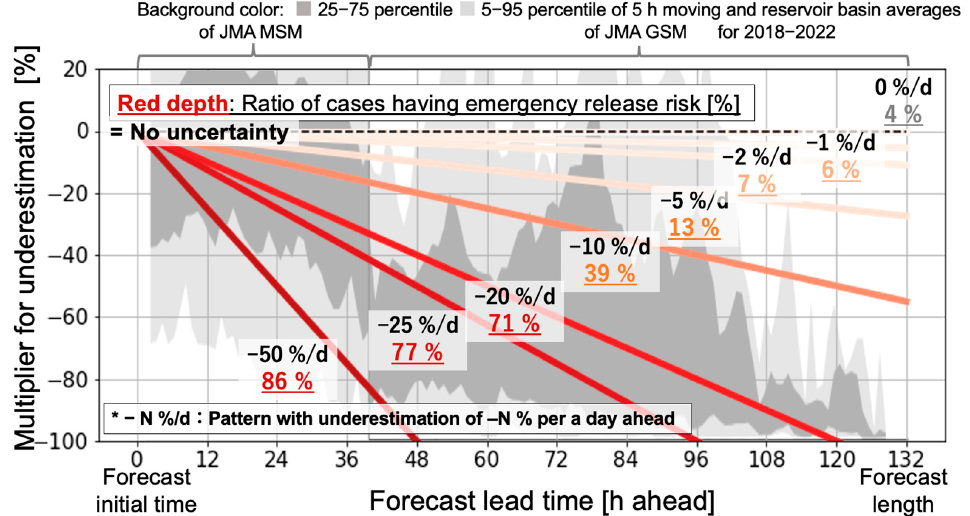
Figure 17. Another version of Figure 16 shown on the forecast pa tt erns’ variations. Ratio ( %) of cases with an emergency release risk when using variously underestimated rainfall forecasts for all pre-release cases. − N %/d: a pa tt ern with underestimation of − N % per a day ahead. 5 h moving and reservoir basin averages of the JMA rainfall forecast (MSM ~39 h/GSM 40 h~) is represented in background color: gray for 25–75 percentile and light gray for 5–95 percentile.